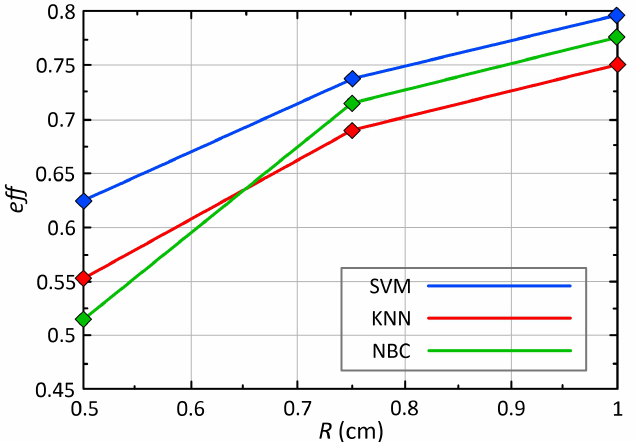
Figure 19. The effectiveness of MWR diagnostics ( ef f ) vs. the tumor radius for various machine learning methods.